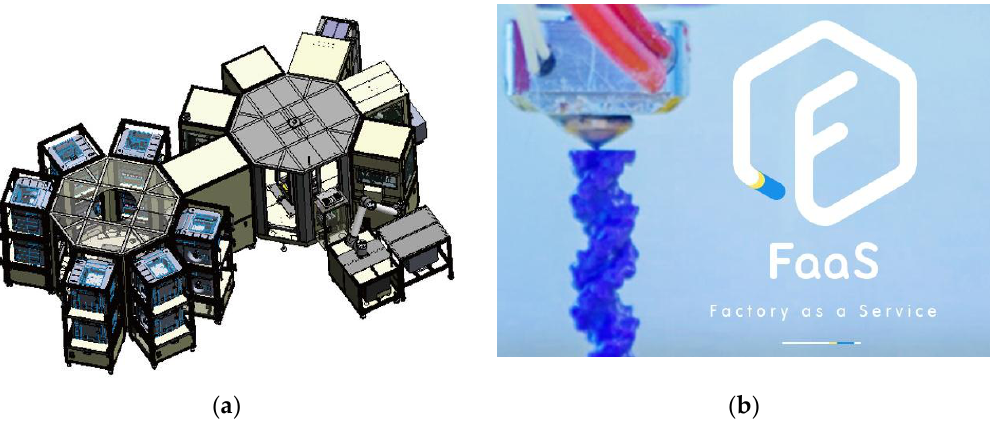
Figure 1. Connected smart factories and the cloud system. ( a ) Smart Factory; ( b ) Cloud System.